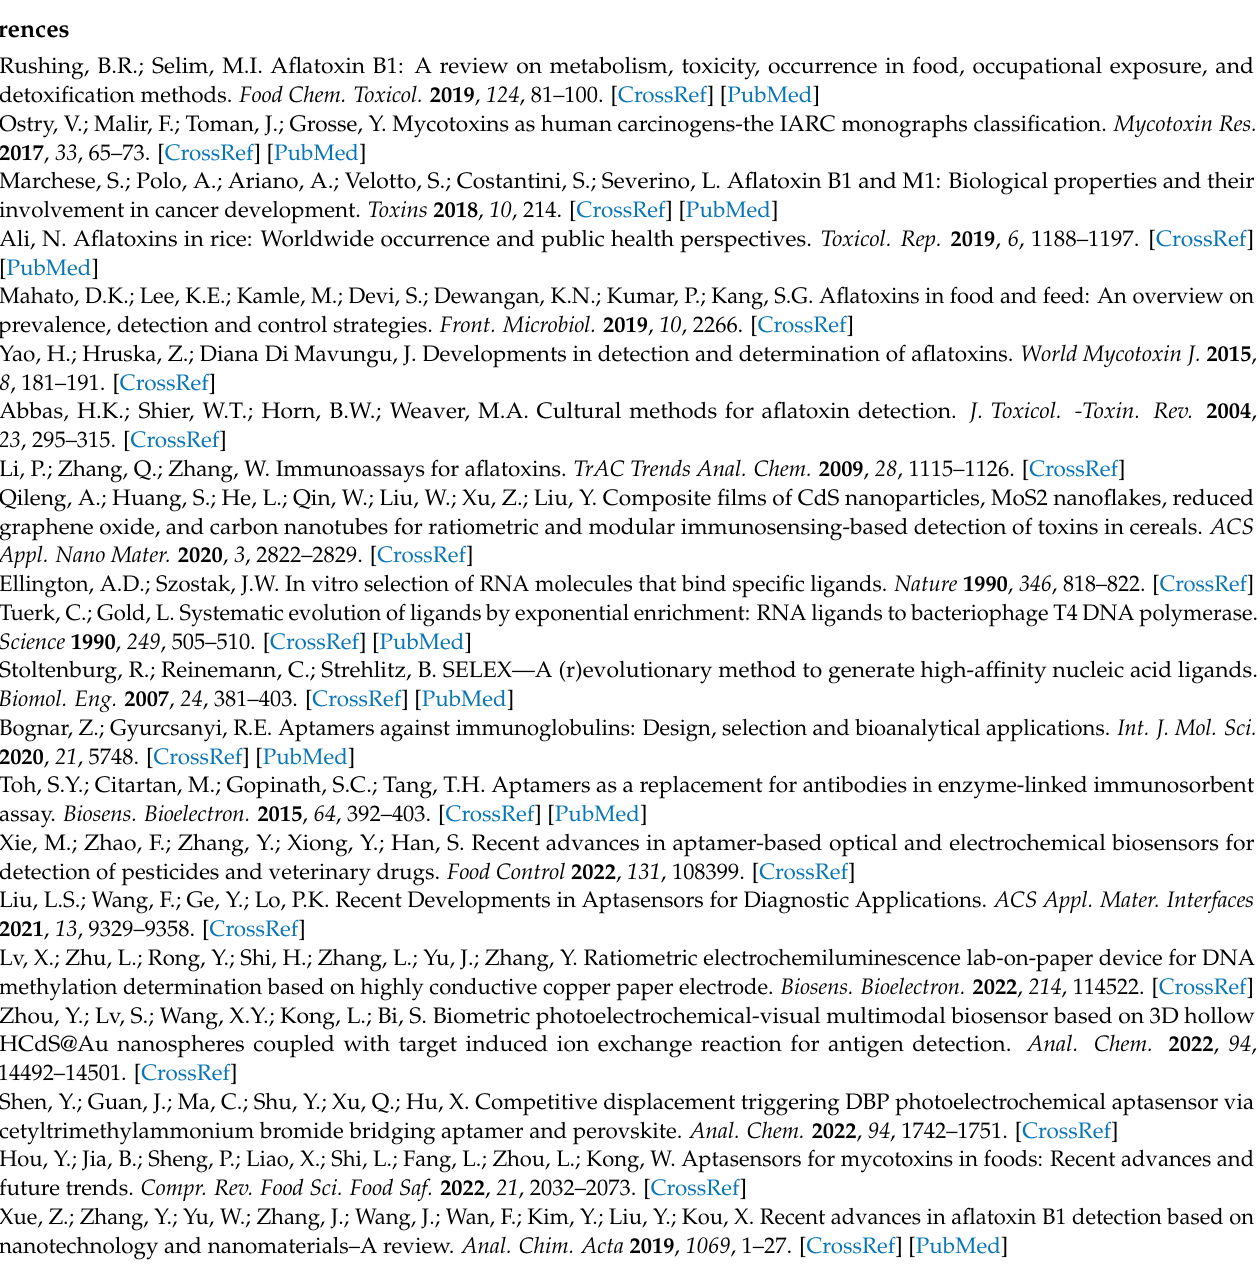
tration; Figure S3: optimization of MgCl2 concentration in assay buffer; Figure S4: effects of NaCl concentration in assay buffer on detection performance of this proposal